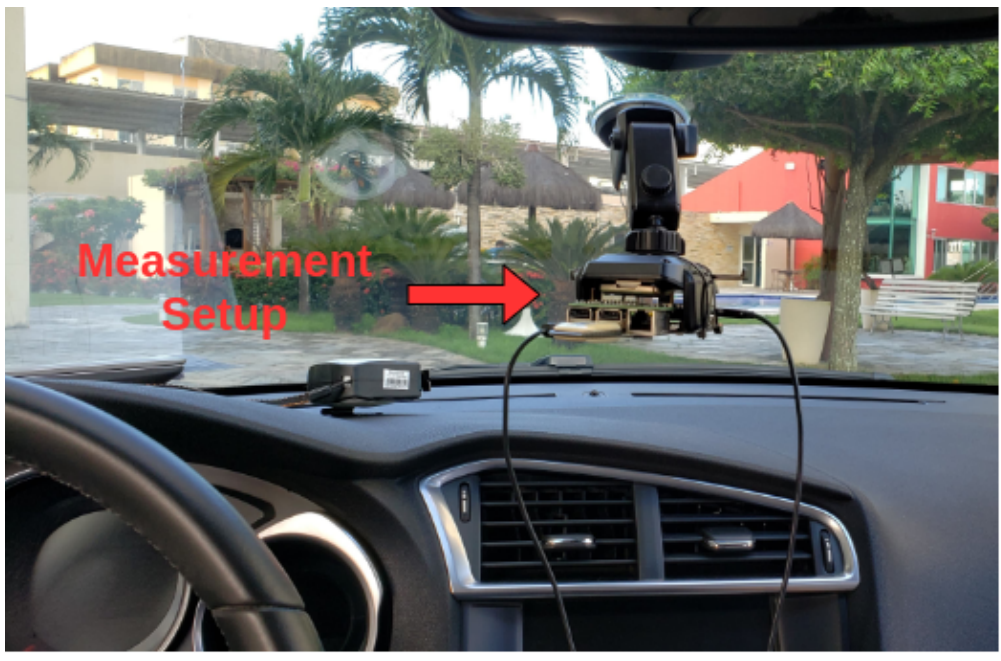
Figure 3. The measurement setup.